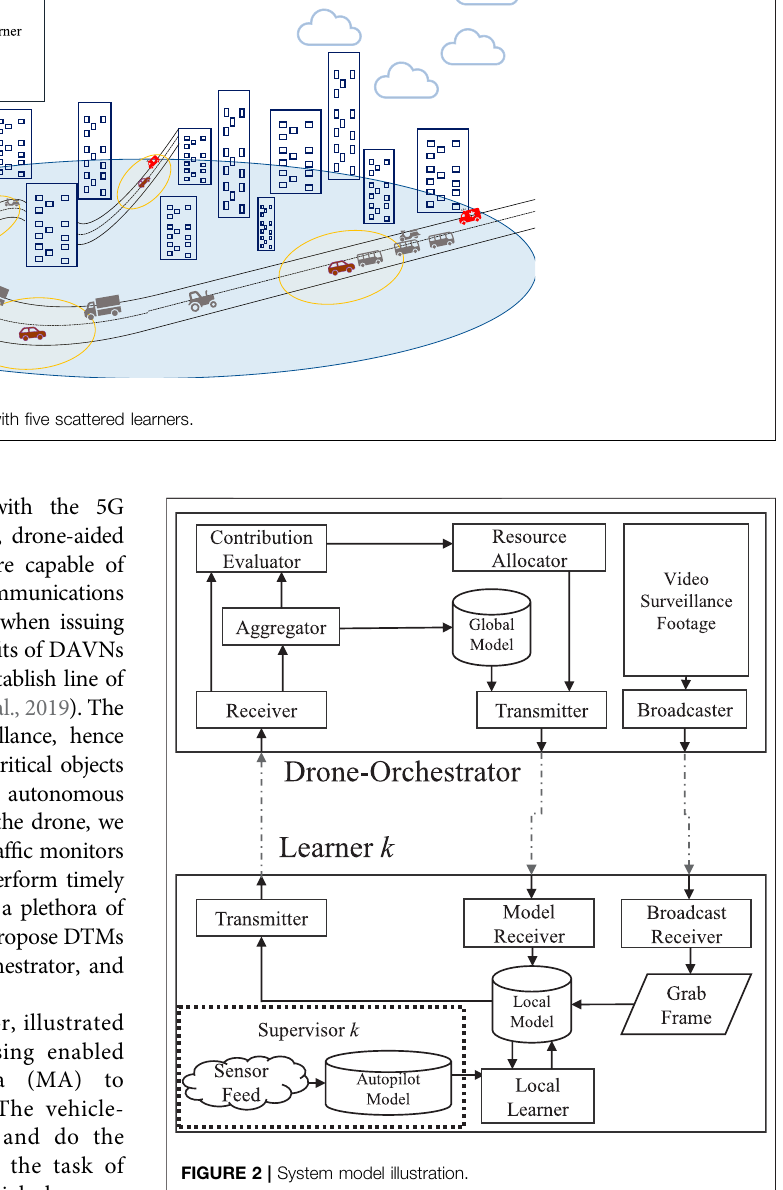
FIGURE 2 | System model